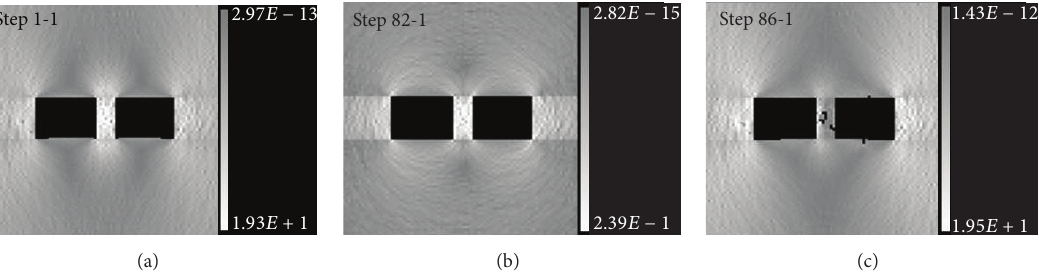
Figure 6: Plot of shear stresses around a pillar with width-to-height ratio = 0.5.